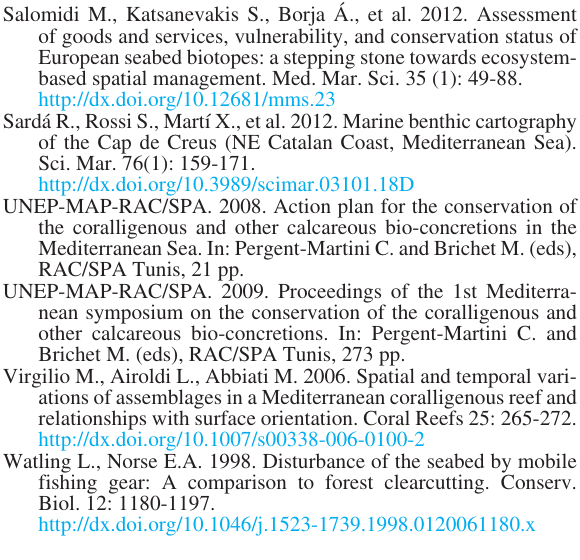
Table S2. – Ligurian localities with coralligenous and main char- acteristics. N/A, No data available. * Facies not included in the EUNIS Habitat 2004 classification for Mediterranean corallig- enous communities. Table S3. – List of sessile megabenthos taxa reported by different authors for the Ligurian coralligenous